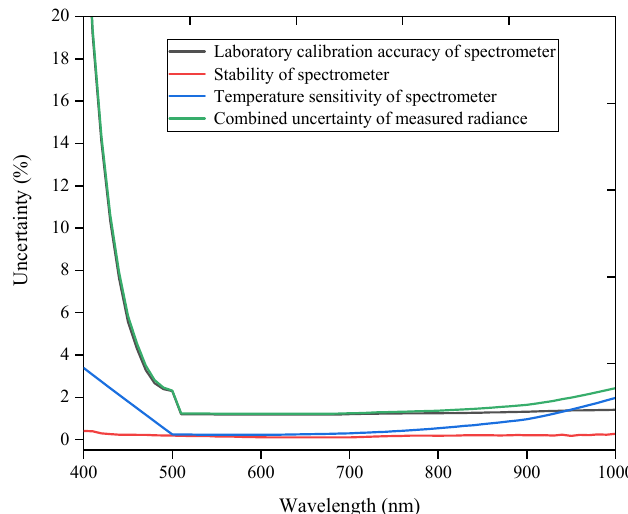
Figure 9. The combined uncertainty of the measured radiance covering 400 nm to 1000 nm due to the laboratory calibration accuracy, the stability, and temperature sensitivity of the spectrometer during in situ measurement.